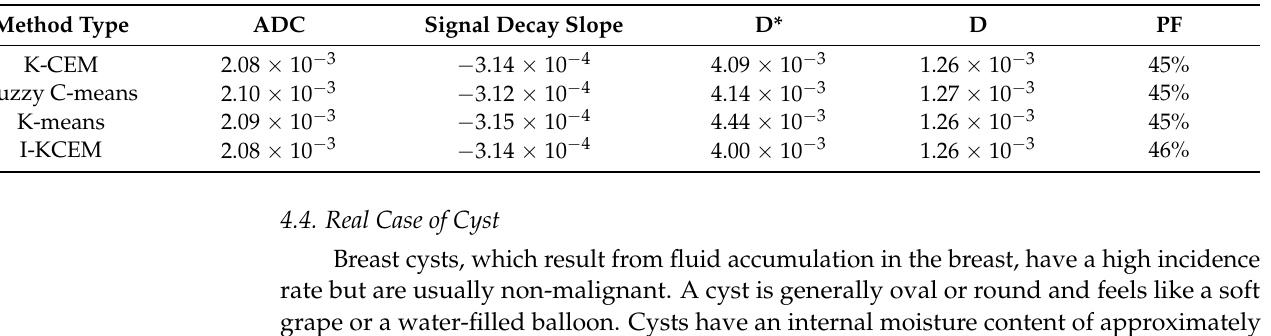
Figure 13. Eighth-slice IVIM-DW images of a fibroadenoma with b values of ( a ) 0, ( b ) 15, ( c ) 30, ( d ) 45, ( e ) 60, ( f ) 100, ( g ) 200, ( h ) 400, ( i ) 600, ( j ) 1000, ( k ) 1500, ( l ) 2000, and ( m ) 2500 s/mm 2 . ( n ) Dynamic contrast-enhanced T1-MR image. ( o ) Tumor detection by I-CEM, K-CEM, K-means, and FCM. Table 3. Results of applying different detection methods to a fibroadenoma